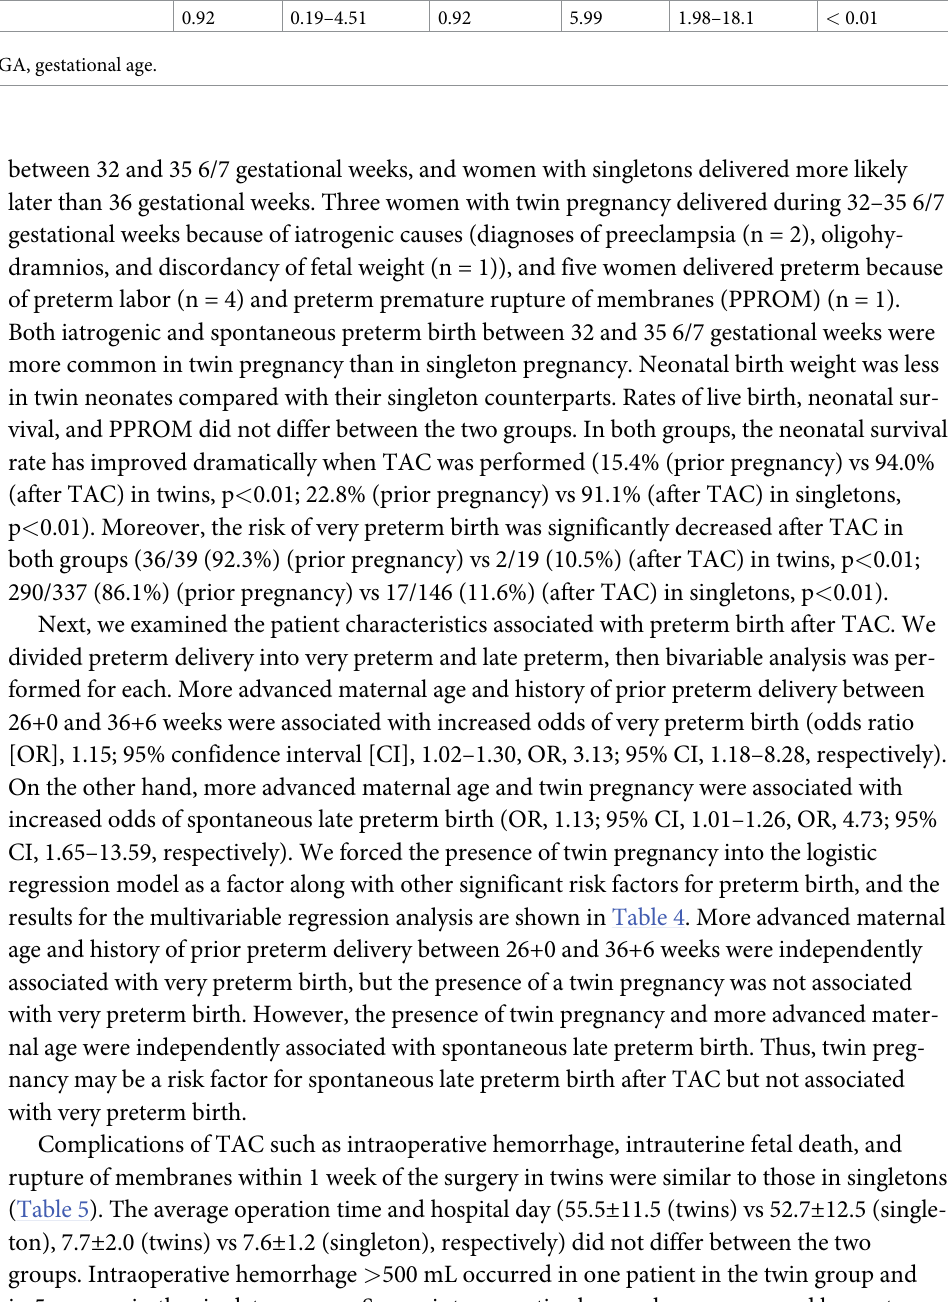
aOR, adjusted odds ratio; CI, confidence interval; GA, gestational